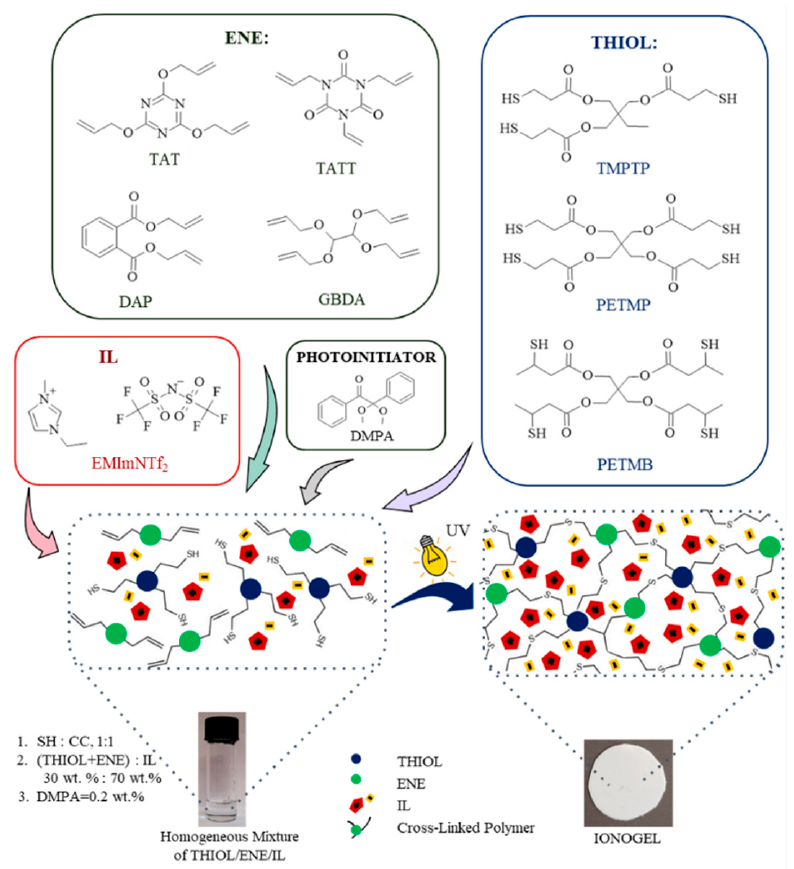
Figure 9. Schematic illustration of the synthesis of ionogel.